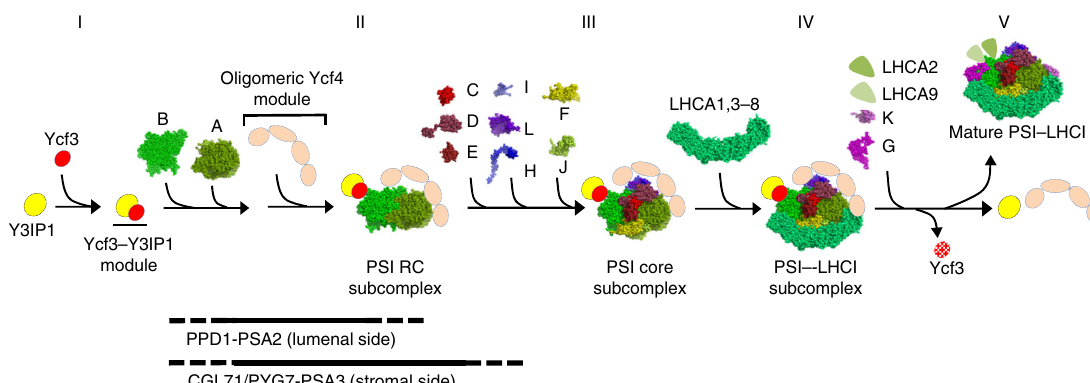
Fig. 6 Proposed model of PSI complex assembly. Newly synthesized Ycf3 associates with stable Y3IP1 to form a Ycf3 – Y3IP1 module in the thylakoid membranes (stage I). This module mediates the assembly of newly synthesized PsaB and PsaA into a reaction center (RC) heterodimer (stage II). PPD1and PSA2 may assist PSI RC assembly from the lumenal side, whereas CGL71/PYG7 on the stromal side together with PSA3 may assists oxygen